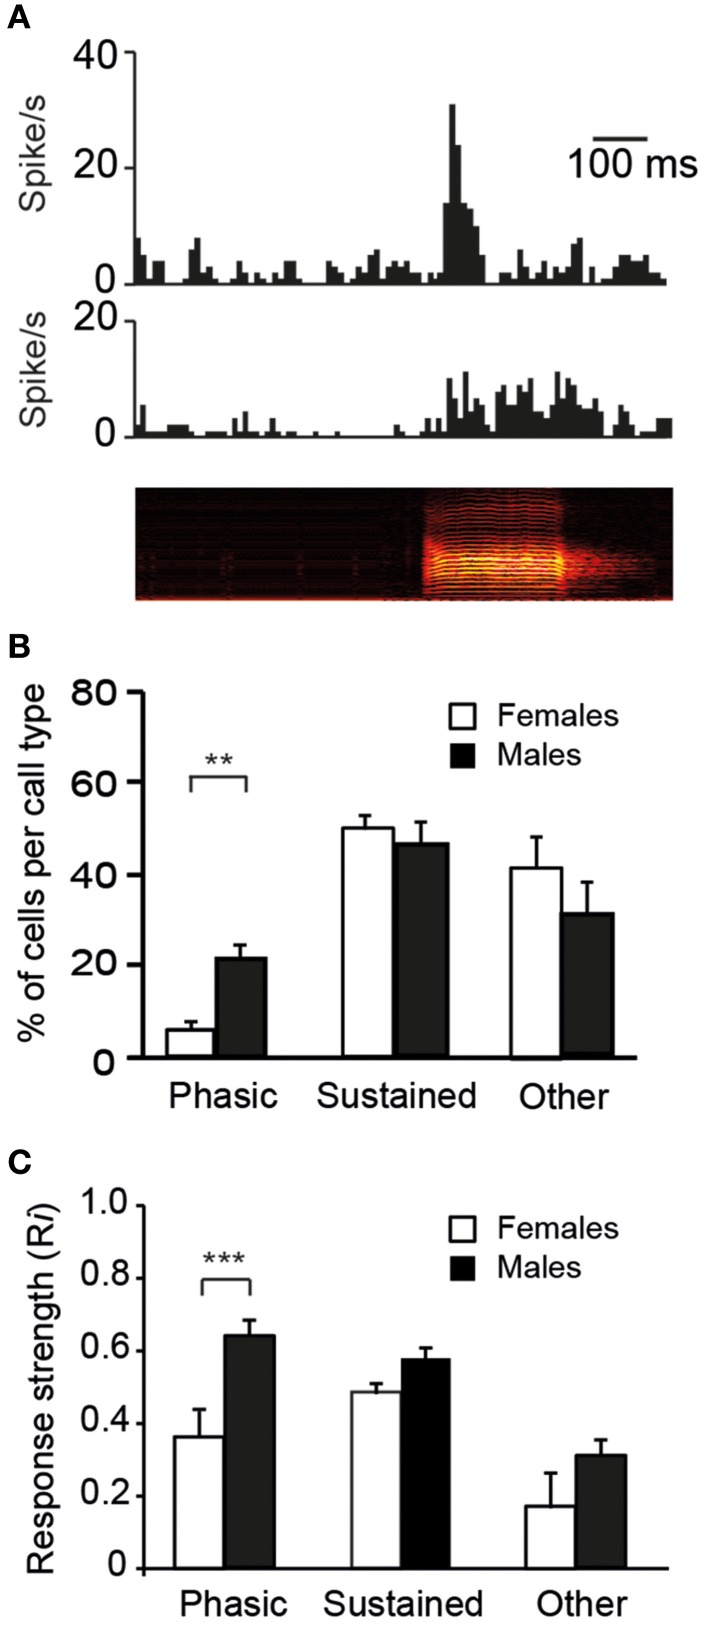
The diversity in responses to calls by single units in the CLM. (A) Representative examples of a phasic (top) and a sustained (middle) response to the playback of a call stimulus (bottom). The call stimulus is depicted as a spectrogram. (B) The mean proportion of cells per call type within each of the three categories of responses: phasic, sustained, and other which includes an absence of response and/or an unidentified profile of response (**p < 0.01). In response to each call type, we quantified the number of cells according to the profile of the response. (C) Average response strength. Call stimuli induce stronger phasic responses (Ri values) in males than in females (***p < 0.001). Each bar represents the mean ± SEM.